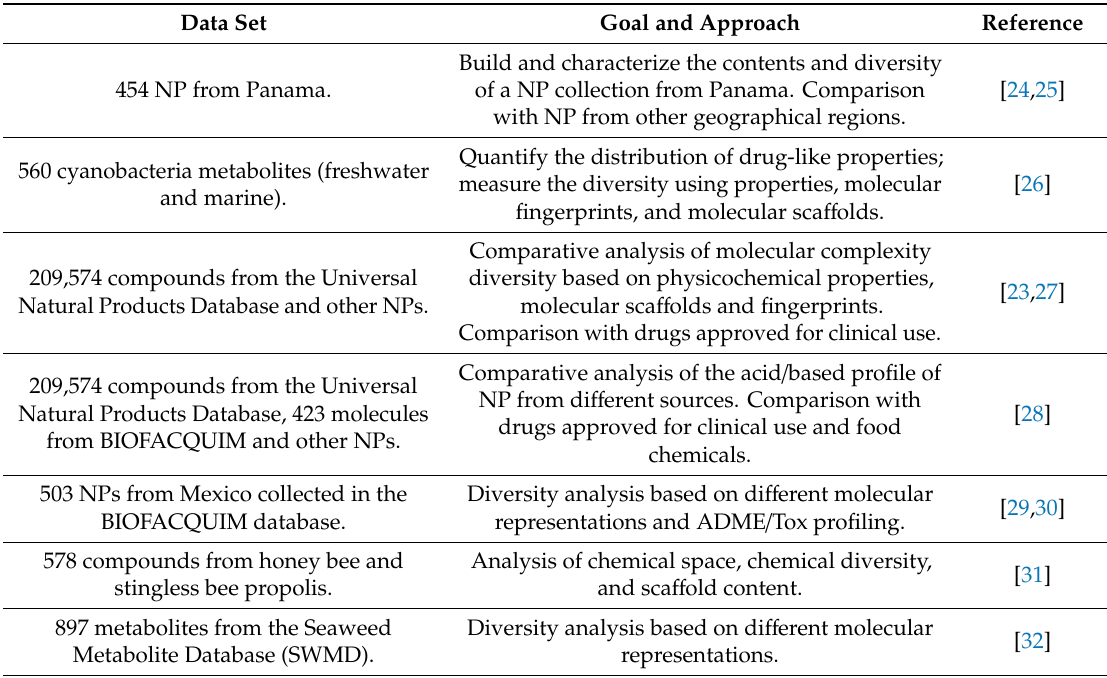
Table 1. Examples of recent chemoinformatic profiling of natural products (NPs) data